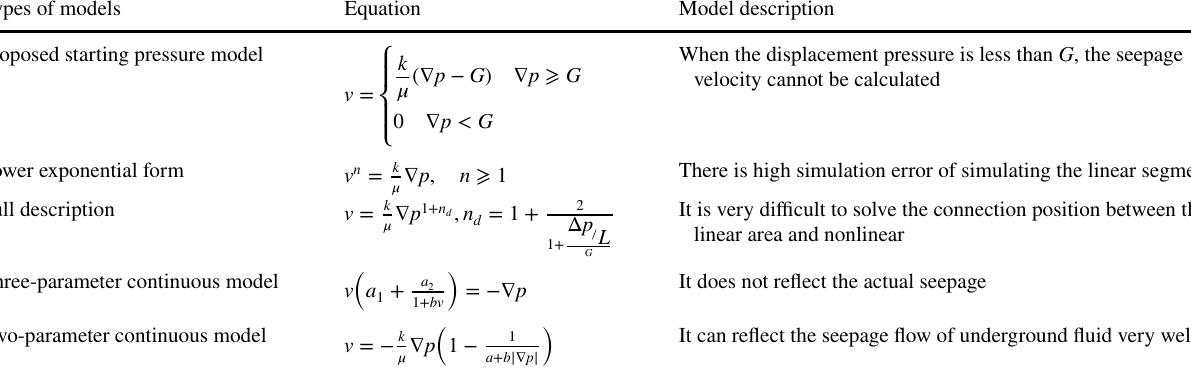
Fig. 1 The illustration of an injection-producing unit for a fractured five-spot pattern and its CUs Table 1 Nonlinear mathematical